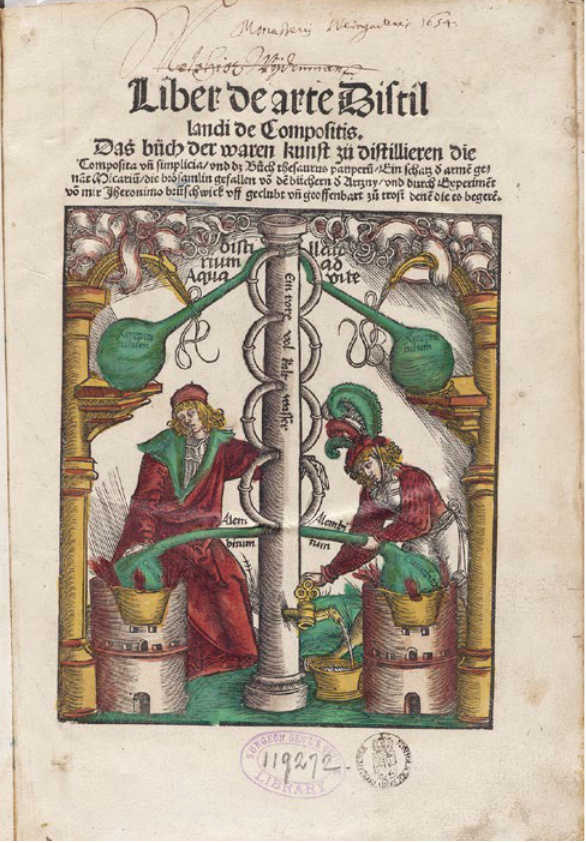
Figure 3. Title page of the book Liber de arte Distillandi de